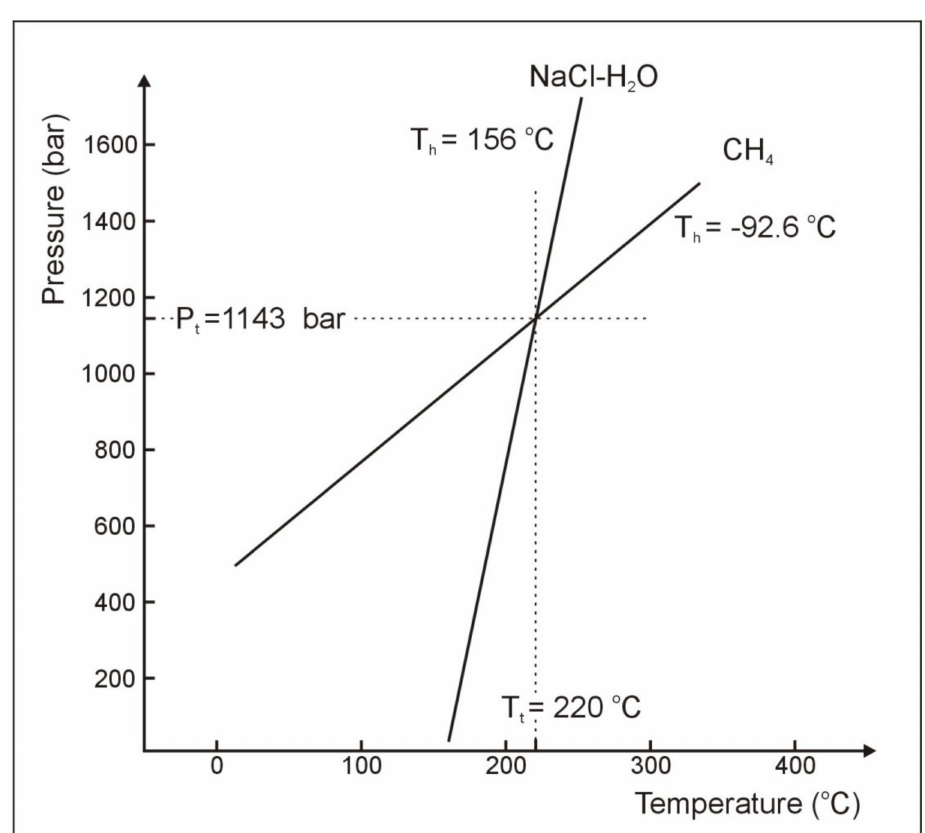
Figure 11. The estimation of P-T trapping conditions for AQFI (brine) and HCFI 1 (methane) in the Katarzynin 2 borehole (depth 2510.6